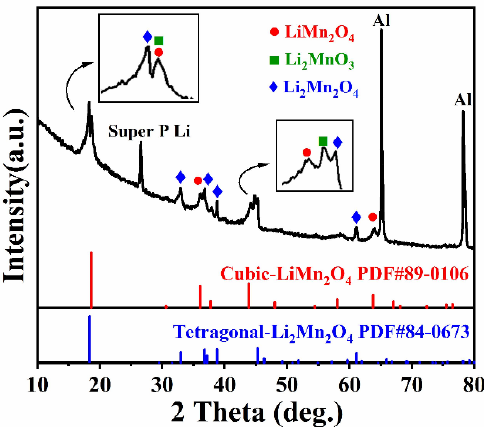
Figure 7. The charging – discharging curves of various samples in the 50th cycle at potential range of 2.0 − 4.8 V ( a – d ).